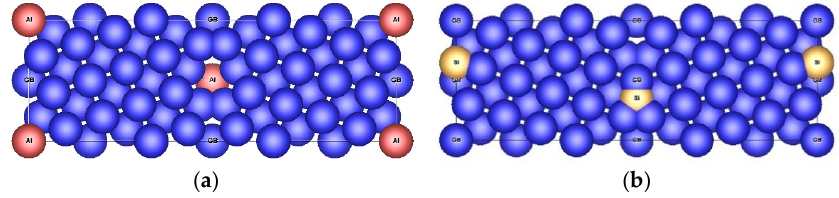
Figure 3. Equilibrium GB supercells containing impurities: ( a ) GB-Ni 118 Al 2(s) , ( b ) GB-Ni 120 Si 2(i) . The blue spheres correspond to Ni atoms, the spheres labelled by “GB” denote the GB plane, the red spheres occupy the position of substitutional impurity atoms, the orange spheres denoted as Si mark the positions of interstitial impurity atoms.